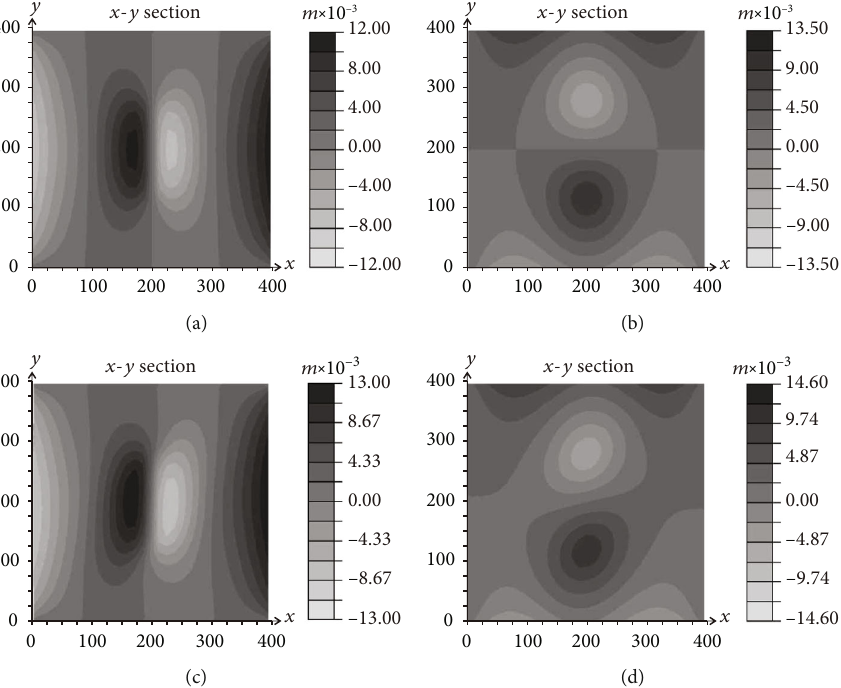
Figure 9: (a) and (b) present u on the x - y section considering natural fractures,